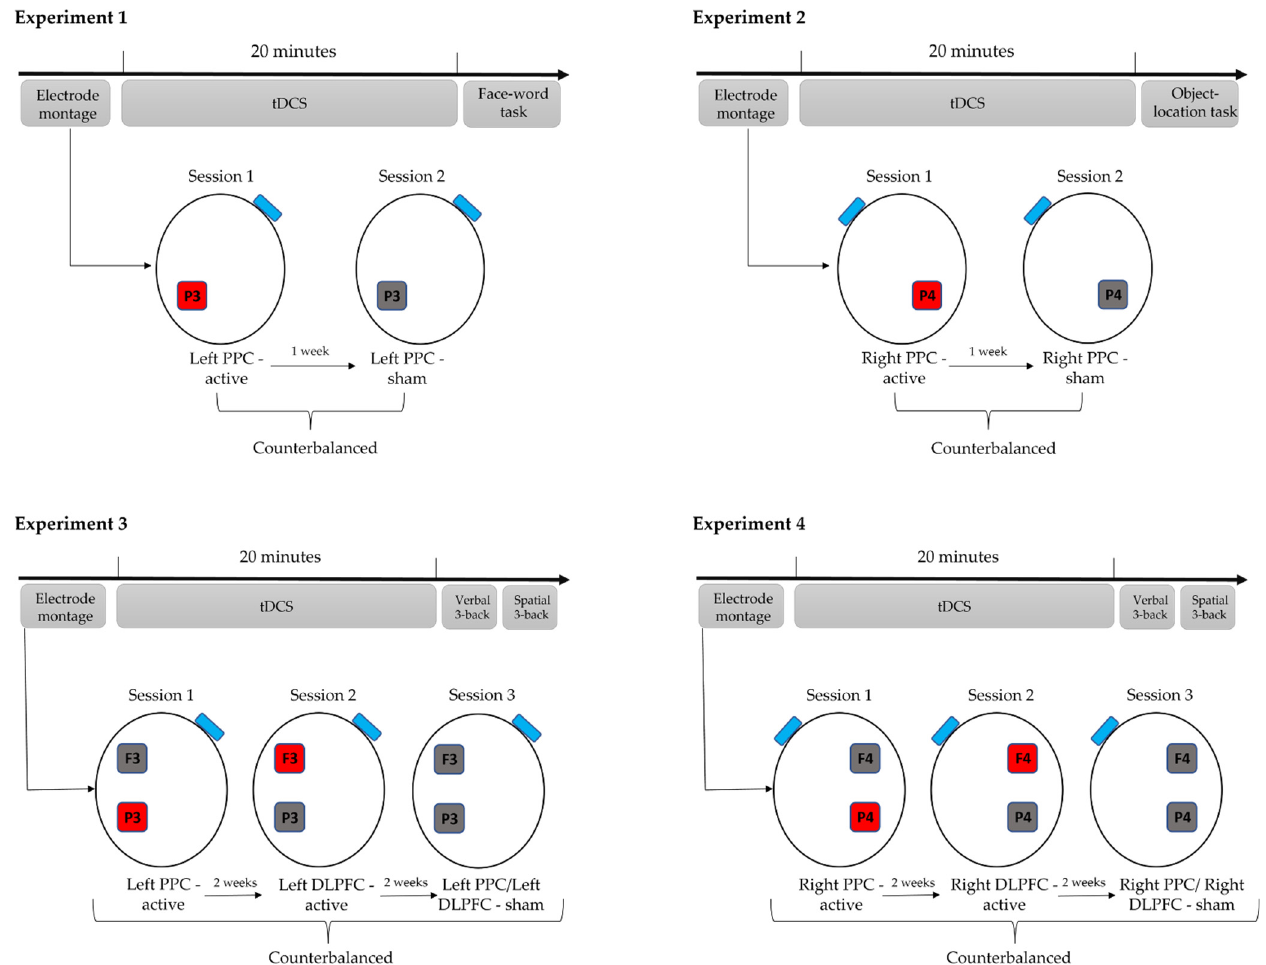
Figure 1. Experimental procedures for Experiments 1–4. The active electrode (anode, marked red) was placed over the cortical targets, i.e., left PPC (P3 site of the International 10–20 EEG system) in Experiment l, right PPC (P4 site of the International 10–20 EEG system) in Experiment 2, left PPC and left DLPFC (P3 and F3 site of the International 10–20 EEG system) in Experiment 3, and right PPC and right DLPFC (P4 and F4 site of the International 10–20 EEG system) in Experiment 4. In each experiment, the return electrode (cathode, marked blue) was placed over the contralateral cheek. The inactive electrode is marked grey. The participants performed memory tasks after the stimulation (offline protocol), and the order of the stimulation conditions was counterbalanced across all experiments. Note: tDCS—Transcranial Direct Current Stimulation; PPC—Posterior Parietal Cortex; DLPFC—Dorsolateral prefrontal cortex; EEG—Electroencephalography.